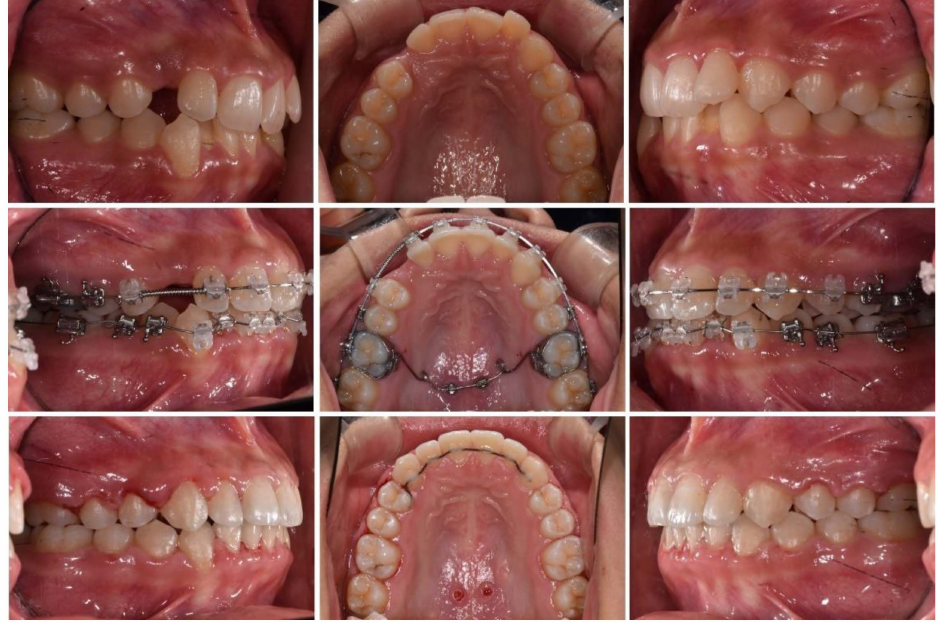
Figure 4. The TADs were inserted on the palatal side of the molars for maxillary molar distalization in combination with a pendulum spring (group 3) From the upper: pretreatment, during treatment, and